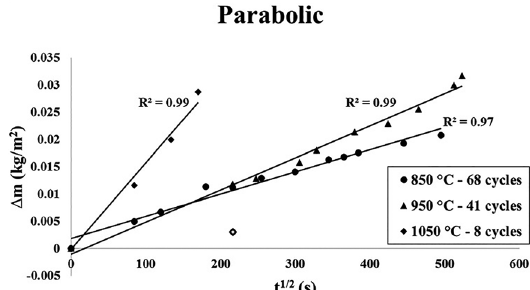
Figure 9. Parabolic kinetic determination for the FeMnSiCrNiCe